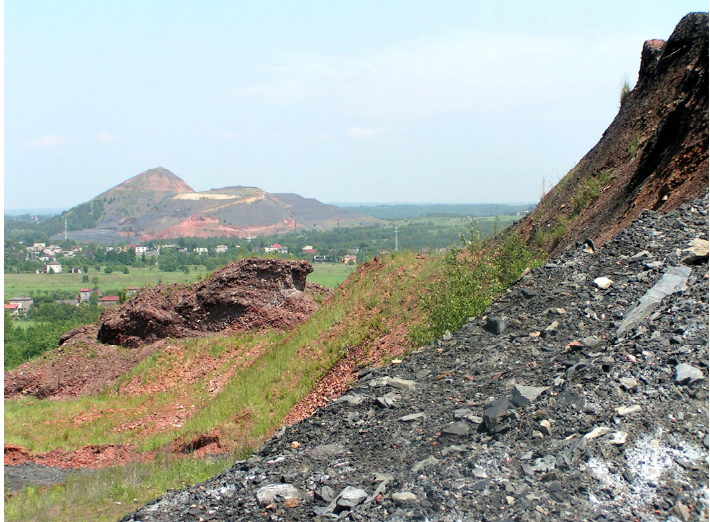
Figure 2. An example of a coal waste dump (Photo by Z. Ró ż a ń ski).